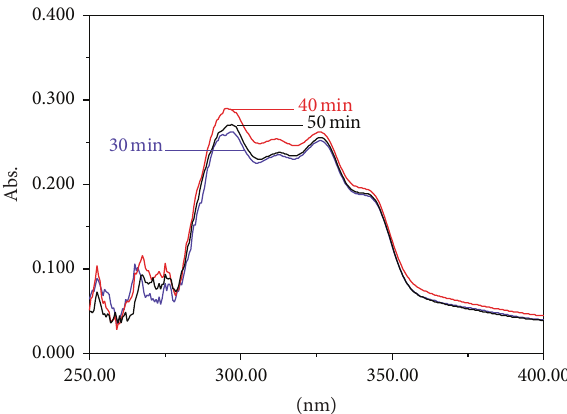
Figure 2: UV spectra of different extraction times.